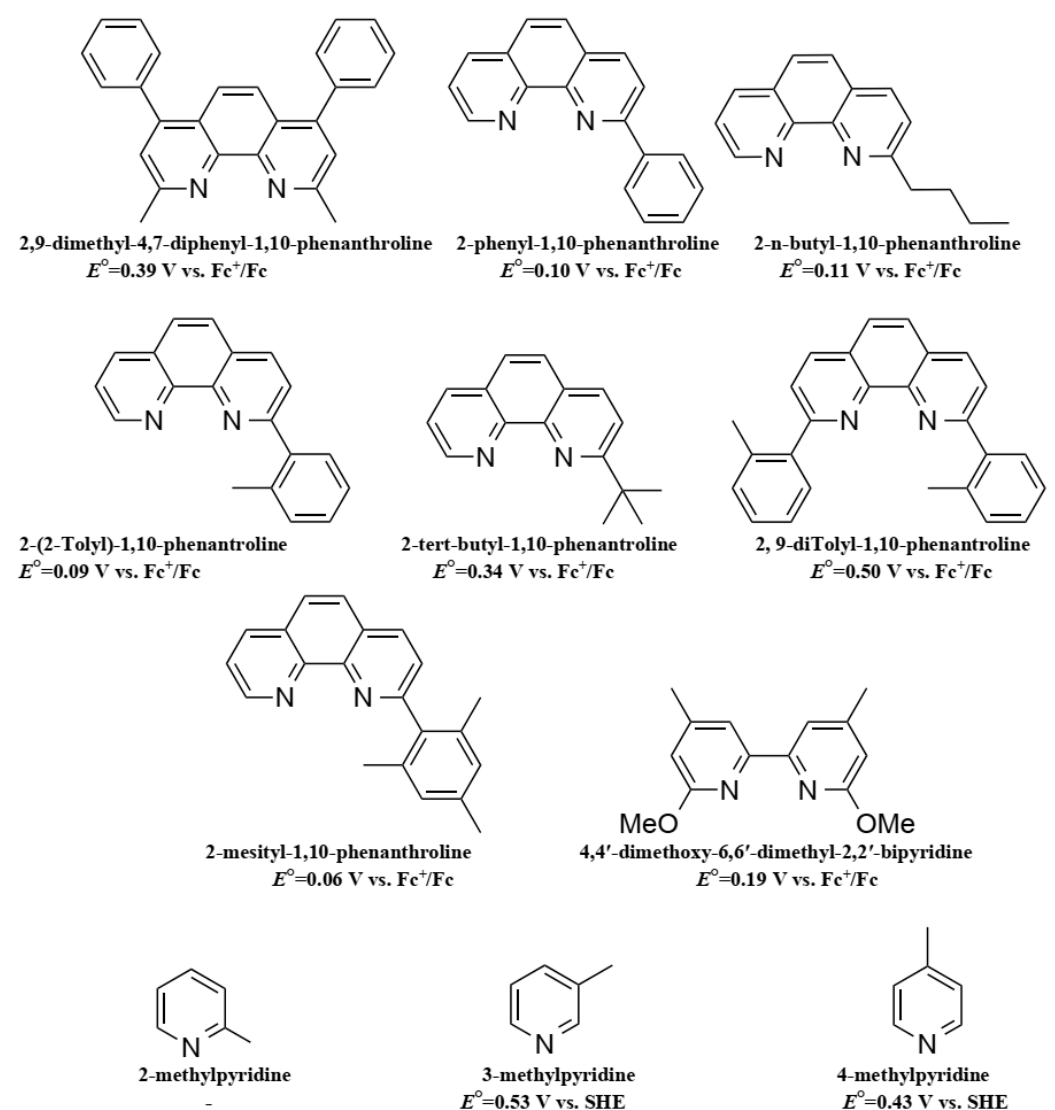
Figure 7. Copper redox mediators and redox potentials reported for DSSC applications.